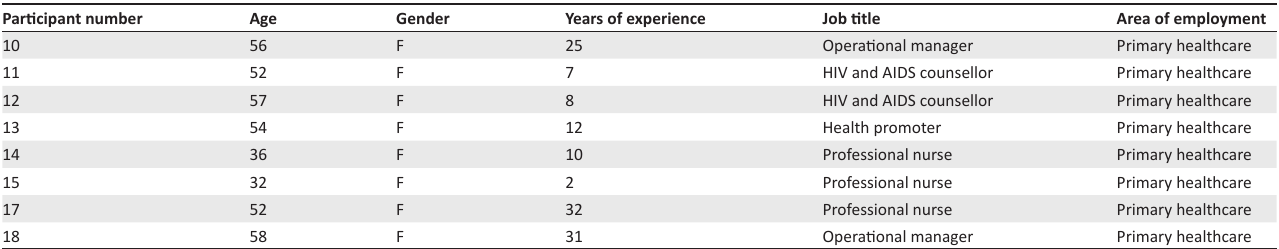
TABLE 2: Profile of participants. Participant